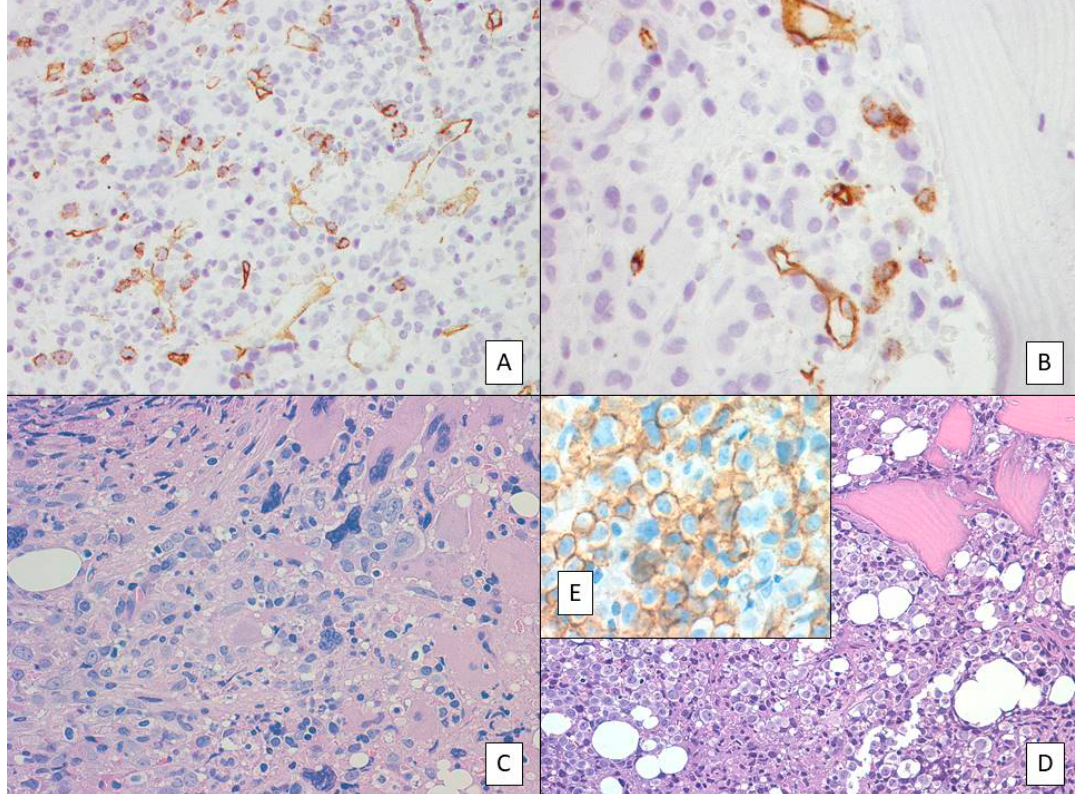
Figure 1. ( A ) Primary myelofibrosis in accelerated phase (AP). Myeloid hyperplasia with increased number of immature precursors and blasts together with large to giant megakaryocytes with hyperlobulated nuclei. ( B ). CD34 immunostaining highlighting the increased number of blasts and their cluster formation. ( C ) Paratrabecular localization of CD34-positive blasts suggests myeloproliferative neoplasm (MPN)-AP. ( D ) AML (M6-FAB) evolution of a case of polycythemia vera (PV). ( E ) Anti-E-cadherin immunostaining documenting the protein expression in the majority of acute myeloid leukemia (AML) (FAB-M6) blasts.